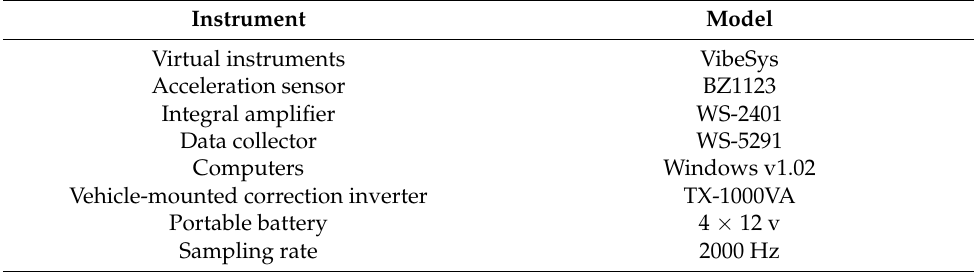
Table 2. Signal acquisition and storage system.